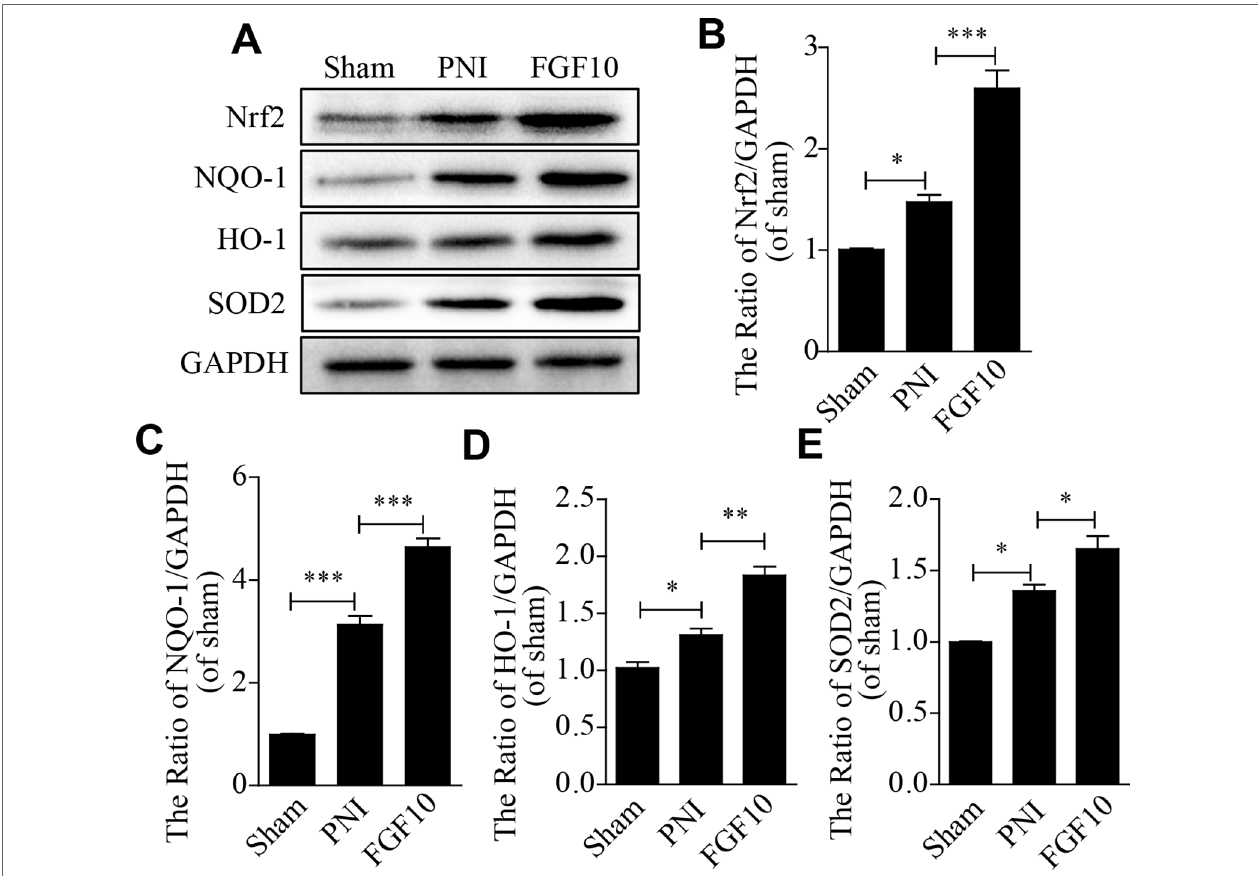
FIGURE 4 | Fibroblast growth factor 10 (FGF10) suppresses oxidative stress after peripheral nerve injury (PNI). (A - E) western blotting analysis showed the expression of Nrf2, NQO1, HO-1, and SOD2 after treatment with FGF10. Data are presented as the mean ± SEM, n = 3. Sham group vs PNI group: * P < 0.05, *** P < 0.001. FGF10 group vs PNI group: * P < 0.05, ** P < 0.01, *** P <